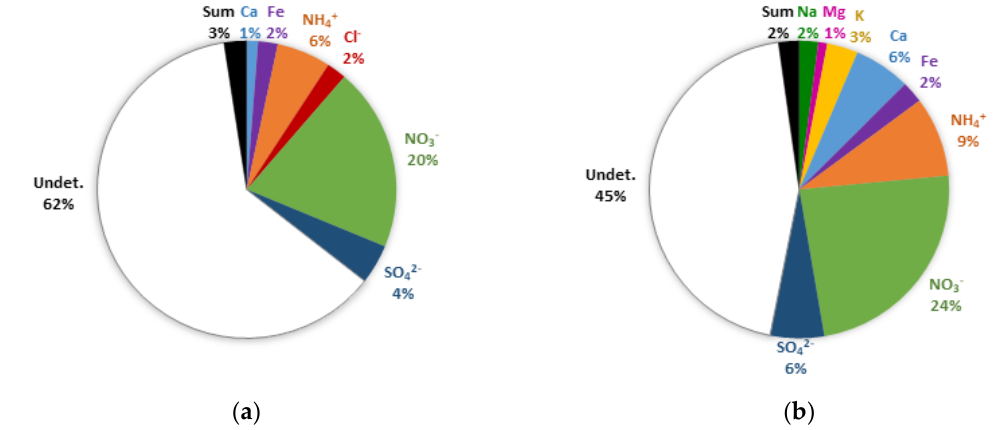
Figure 2. Average composition of the PM 10 samples collected in ( a ) 2012; ( b ) 2014.